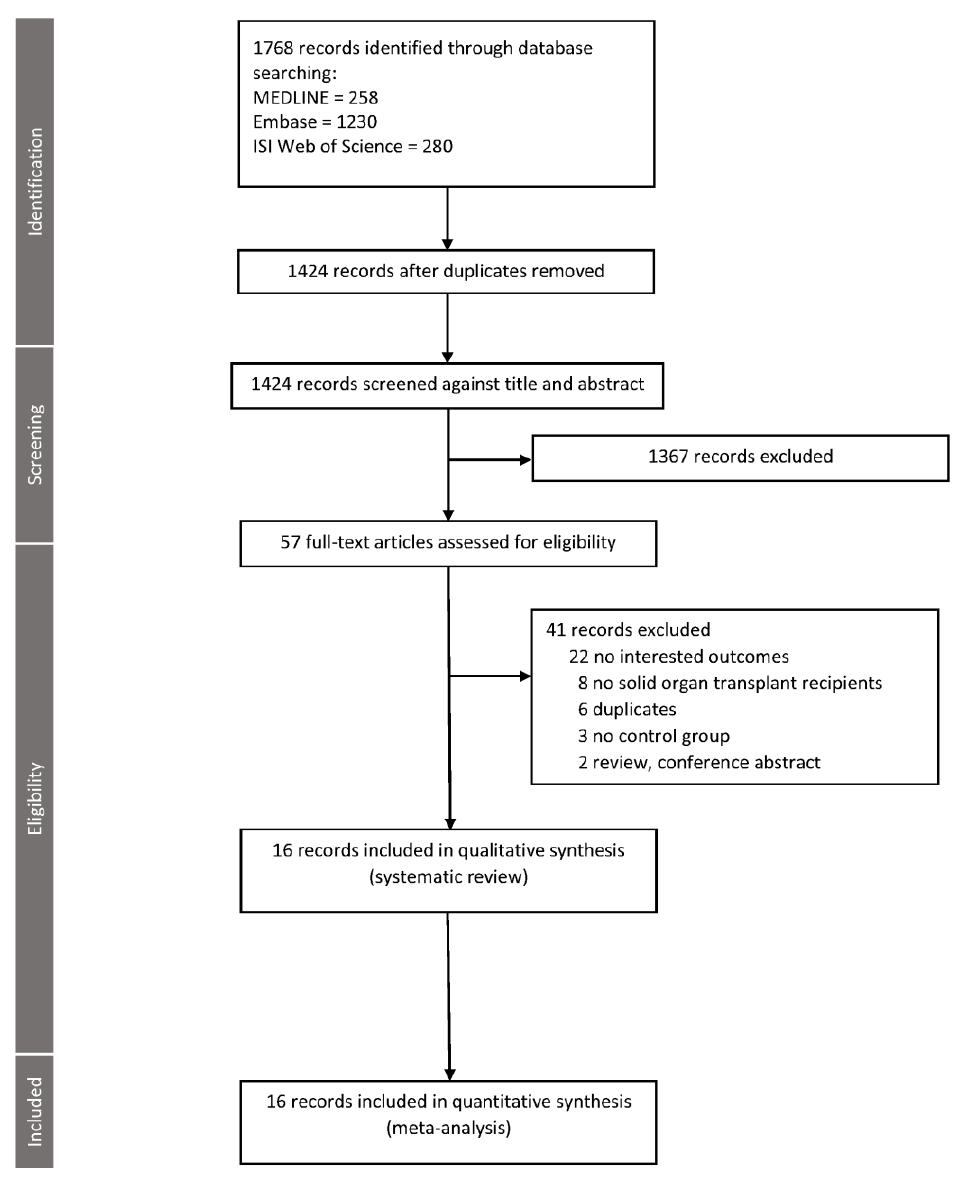
Figure 1. PRISMA flow chart for literature search and study selection.